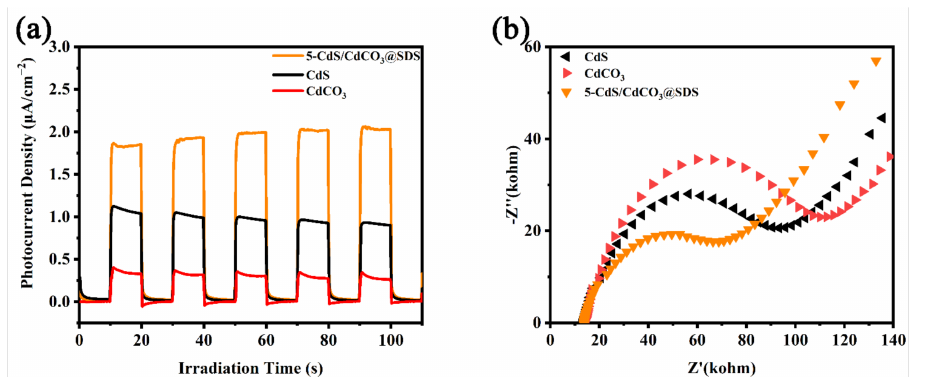
Figure 5. Photocurrent response ( a ) and EIS Nyquist plots ( b ).